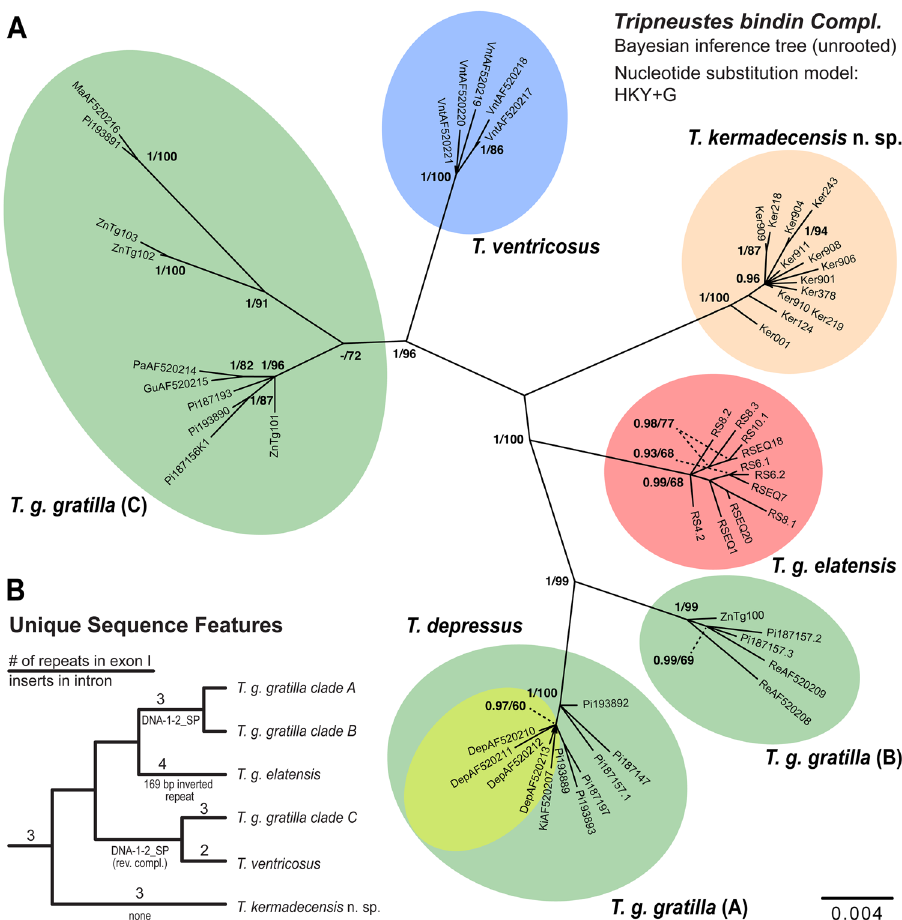
Figure 8. Phylogenetic tree reconstruction of Tripneustes bindin sequences. ( A ) Unrooted BI tree of 1256 bp long Tripneustes bindin sequences including exons 1 and 2 (excluding the glycine-rich repeat in exon 1; see main text for details) and parts of the intron (excluding the 169 bp region identified as transposon, respectively inverted repeat; see main text for details). The tree reconstruction is based on 54 unique haplotypes representing all extant species of Tripneustes . Supporting values ( > 0.9 posterior probabilities and > 60% ML bootstrap values) are shown above the nodes. Color code as in Fig. 5. T . g . gratilla clades ( A – C ) are discussed in the text. Details on the sequences used for this tree are given in the Supplementary Tables S1 and S2. ( B ) Unique sequence features mapped on the bindin tree topology (position of root inferred from COI tree in Fig. 5). Numbers above branches represent number of gylcine rich repeats, names below branches provide information on the nature of insert at the 5 ′ end of the bindin intron (see text for details). Note that the transposon